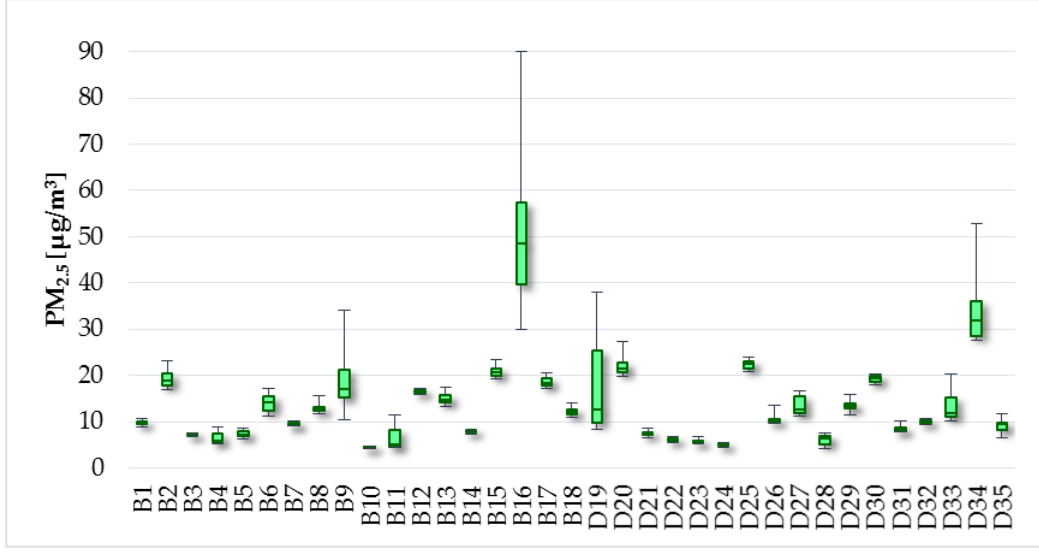
Figure 8. PM 10 concentrations. The measured values of TVOC concentrations in individual objects are illustrated in Figures 9 and 10. The average, minimum, and maximum TVOC concentrations in the apartments were 519.7 µg/m 3 , 28 µg/m 3 , and 2393.5 µg/m 3 , respectively. TVOC levels were slightly lower in the family houses, with average value of 330.2 µg/m 3 , minimum value of 13.5 µg/m 3 , and maximum value of 1712 µg/m 3 . The recommended value for TVOC concentrations is 200 µg/m 3 according to Mølhave [38]. This value was exceeded in 69% of households (94% of apartments and 41% of family houses).